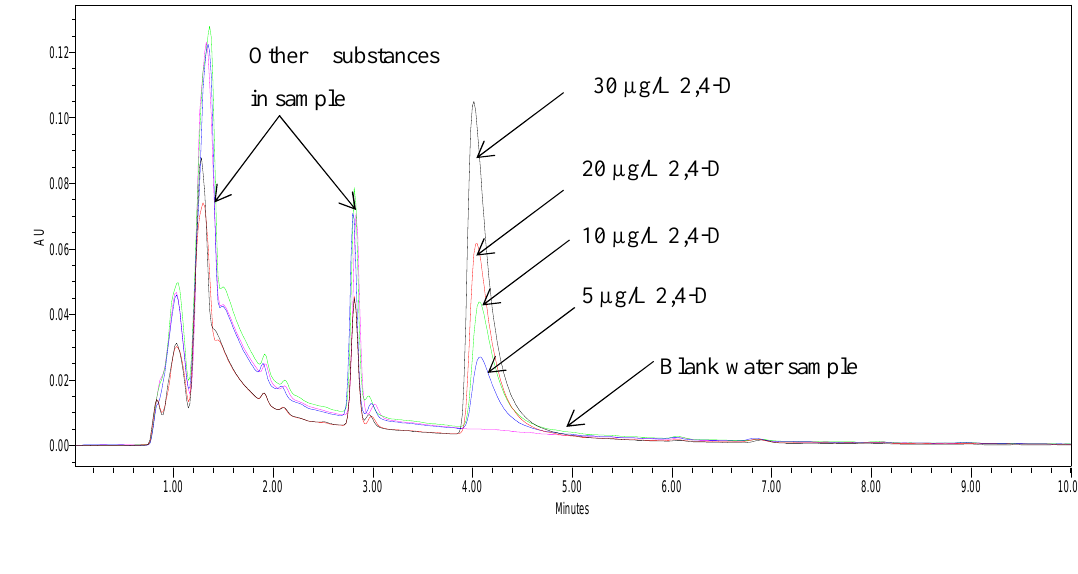
Table 2. A comparison of 2,4-D in water samples determined by both the biosensor and HPLC